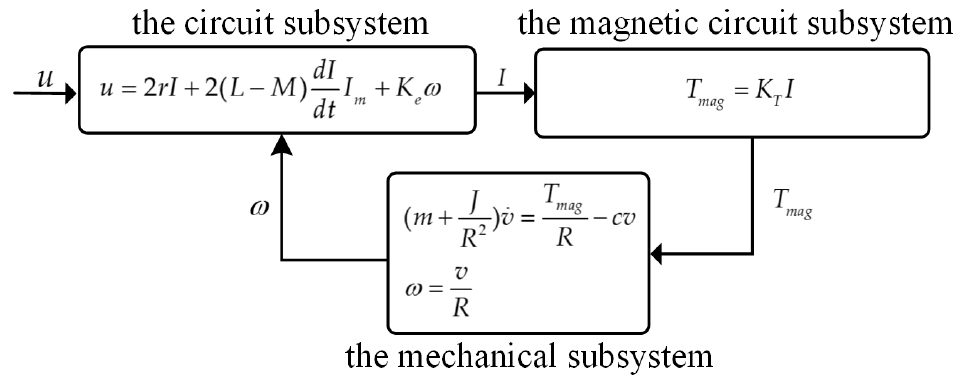
Figure 8. Coupling of subsystems of the FVVA system.